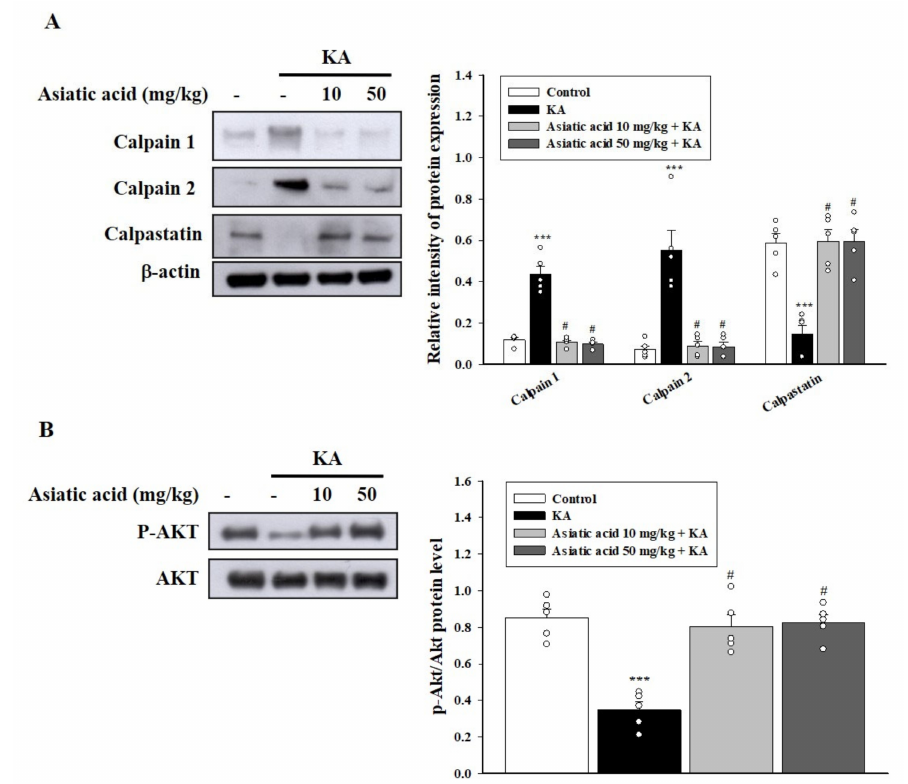
Figure 4. Effects of asiatic acid pretreatment on the levels of calpain, calpastatin, and p-AKT (protein kinase B) in the hippocampus of rats with KA-induced seizures. ( A , B ) Western blot showing the expression levels of calpain, calpastatin, and p-AKT in the hippocampus for each group. The relative protein levels were quantified. *** p < 0.001 (vs. control); # p < 0.001 (asiatic acid + KA vs. KA); n = 5 rats per